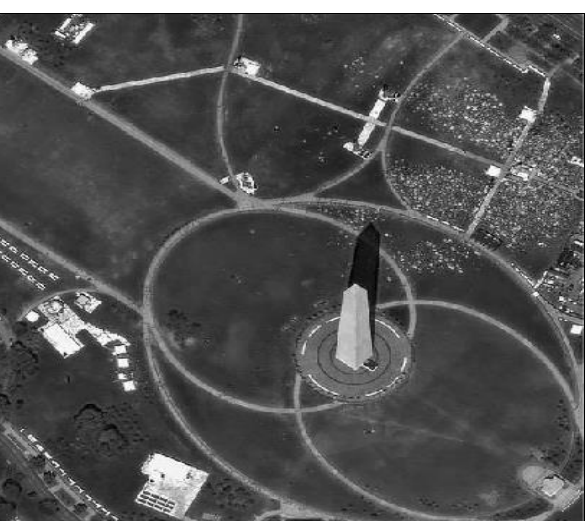
Figure 5. Image obtained after binarization